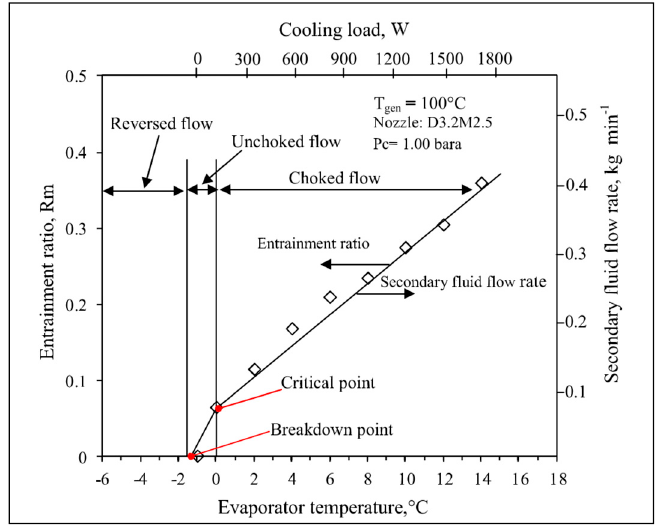
Figure 13. Effect of pressure constraints on ejector operation [62].